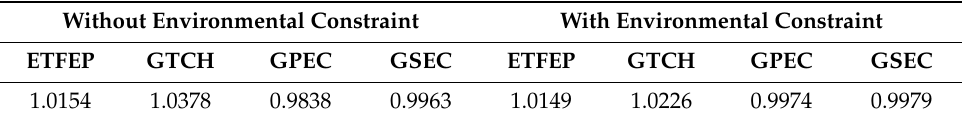
Table 1. Comparison of mean values of ecological total factor energy productivity index. Without Environmental Constraint With Environmental Constraint ETFEP GTCH GPEC GSEC ETFEP GTCH GPEC